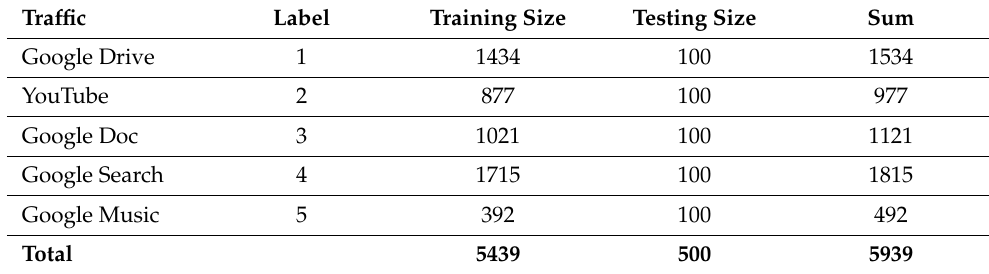
Table 2. No. of instances used for different traffic